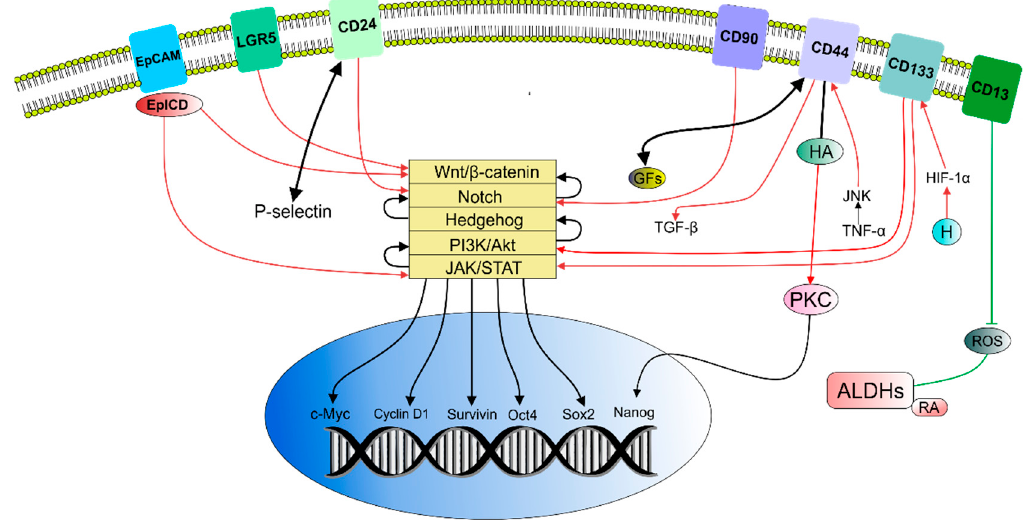
Figure 1. Association between surface markers and promotion of CSCs stem-like properties [3,20,23–41].